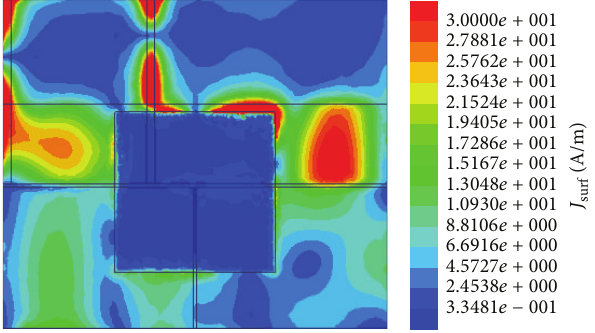
Figure 4: Simulated surface current distribution on the ground plane of the proposed antenna at 5.77 GHz.